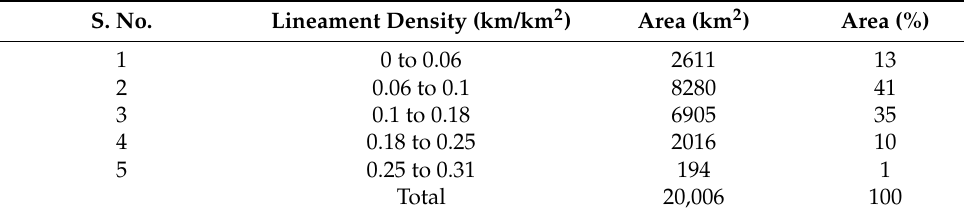
Figure 9. Lineament Density Map of the Study Area. Table 4. Lineament distribution in the study